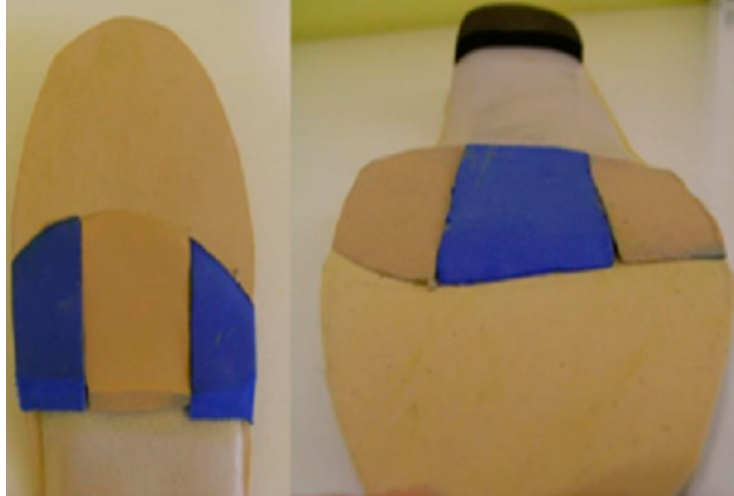
Figure 5. Metatarsal pads with polyurethane foams.